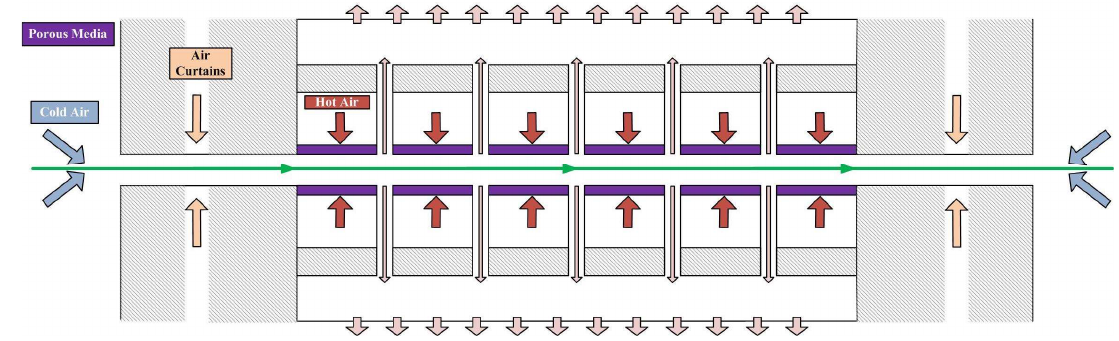
Figure 3. Model scheme with air curtains.